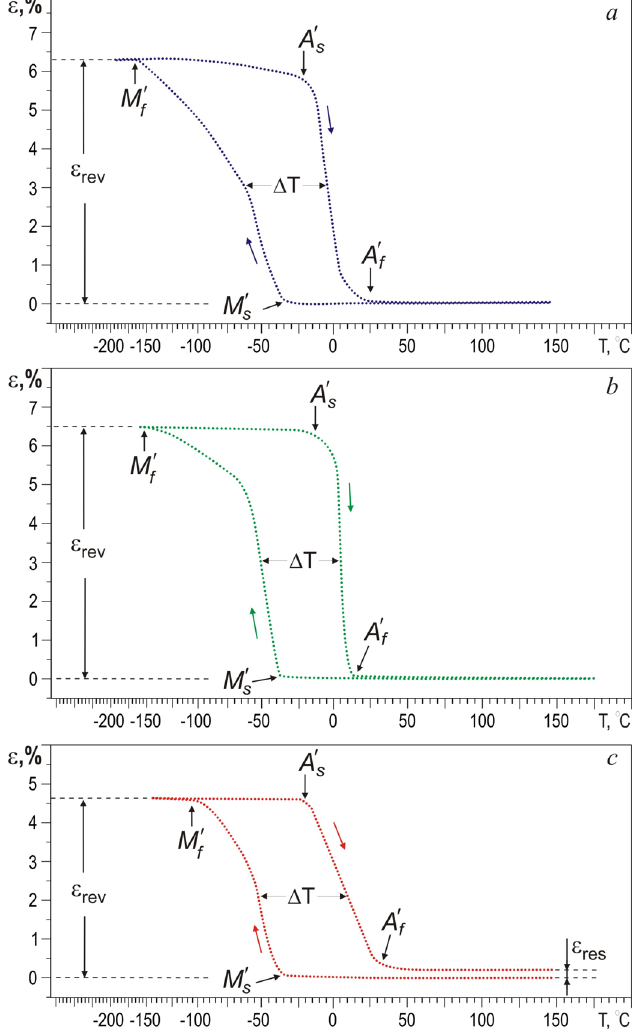
Figure 5. Experimental curves in terms of ε -T of TiNi wires with different content of Ag: 0 ( a ), 0.1 ( b ), and 0.2 ( c ) at.%.